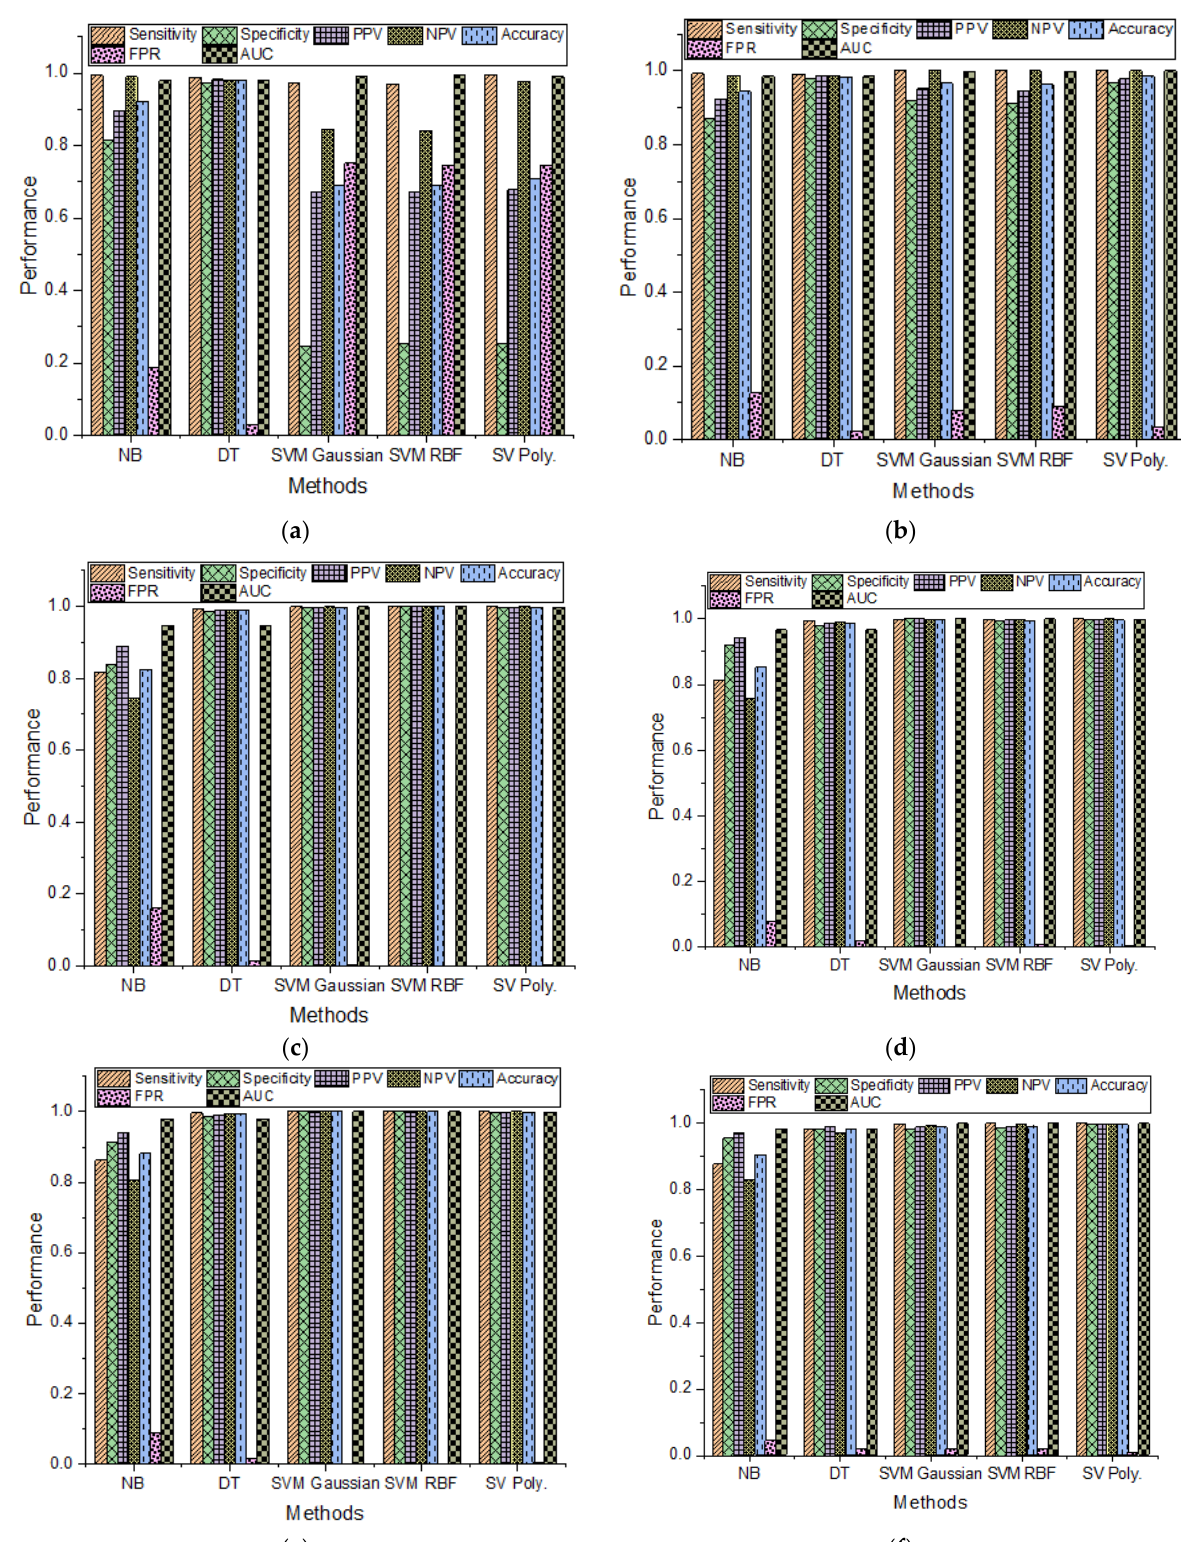
Figure 6. Lung cancer detection based on gamma correction method at different selected gamma values: ( a ) 0.04, ( b ) 0.3, ( c ) 0.5, ( d ) 0.7, ( e ) 0.9, ( f ) 4.0.